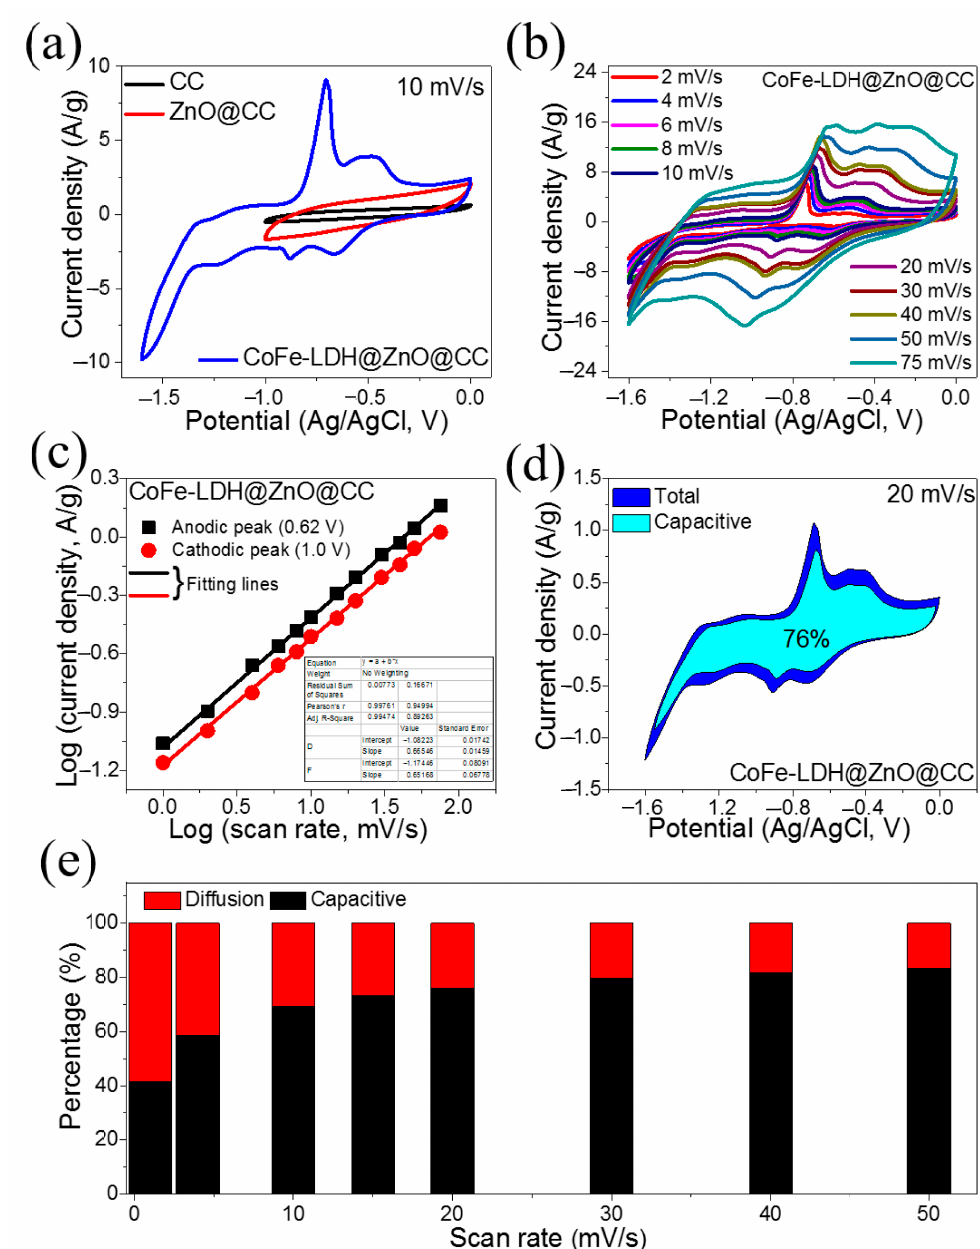
Figure 5. ( a ) CV profiles of the CC, ZnO@CC, and CoFe-LDH@ZnO@CC samples; ( b ) CV pro- files of ZnO@CC and CoFe-LDH@ZnO@CC at different sweep rates; ( c ) Calculation of b -values log(current density) versus log(sweep rate); ( d ) Percentage diffusion/capacitive mechanisms of CoFe-LDH@ZnO@CC; ( e ) Percentage contribution of diffusion/capacitive mechanisms at different sweep rates (1–50 mV/s) for